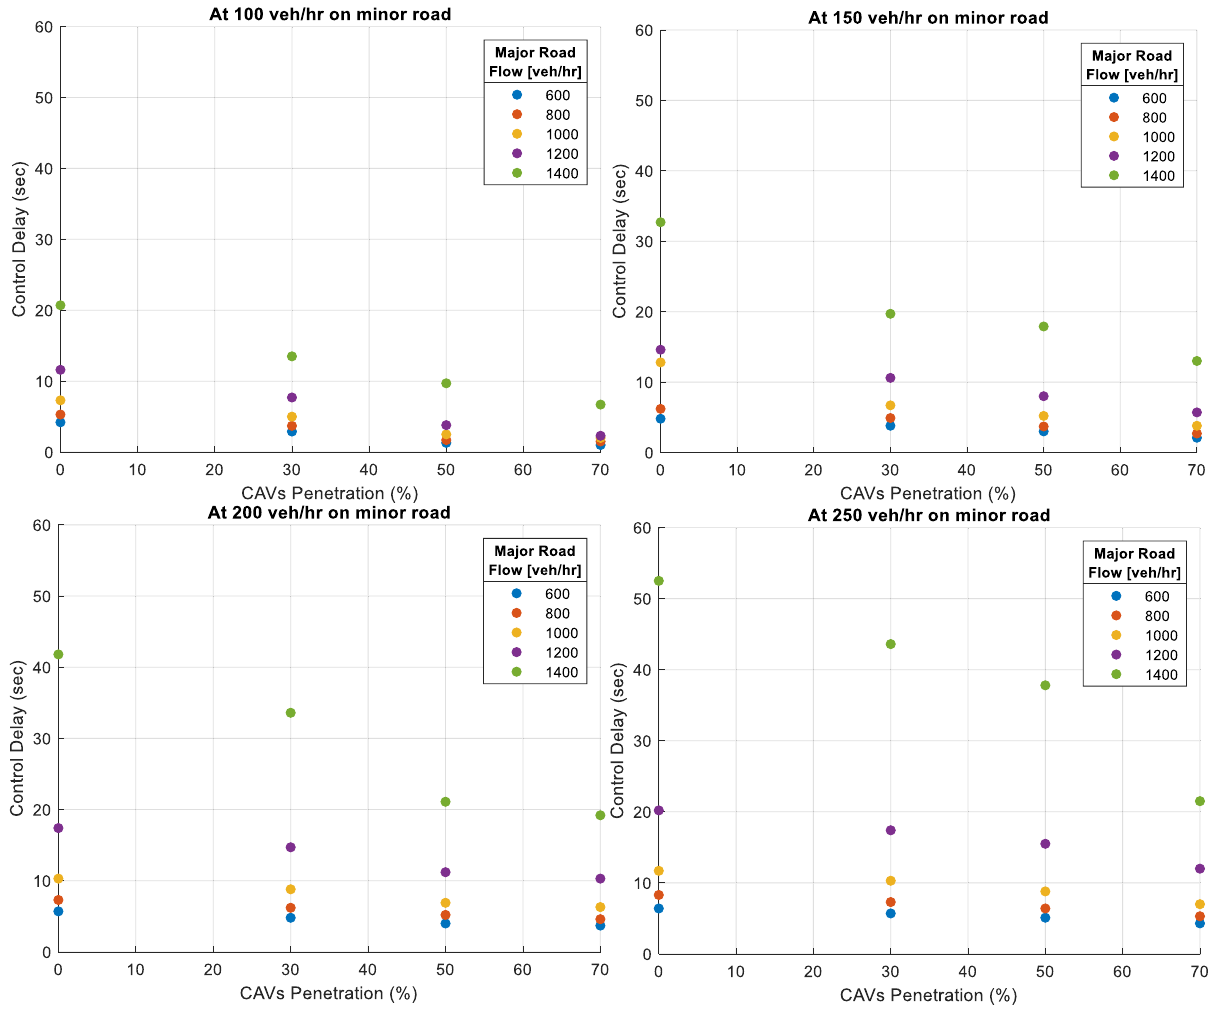
Figure 14: Improvement in control delay at di ff erent levels of CAV